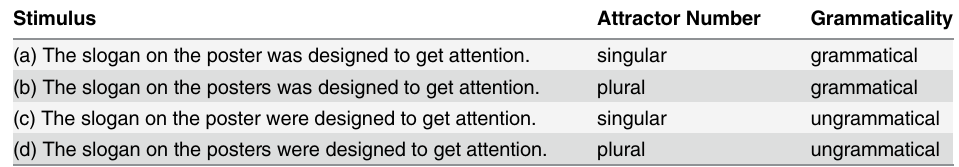
Table 5. Example stimuli set, Experiment